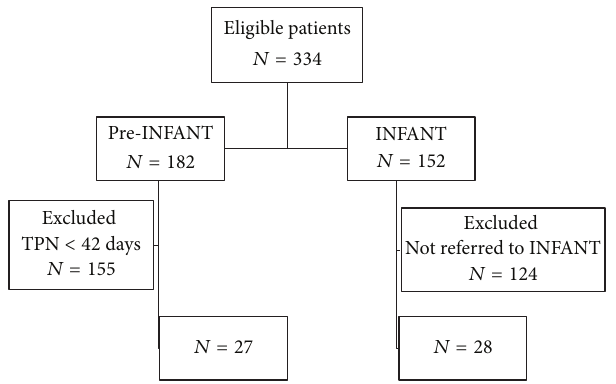
Figure 1: Flow chart of patient selection. INFANT = INtestinal Failure and Advanced Nutrition Team; TPN = total parenteral